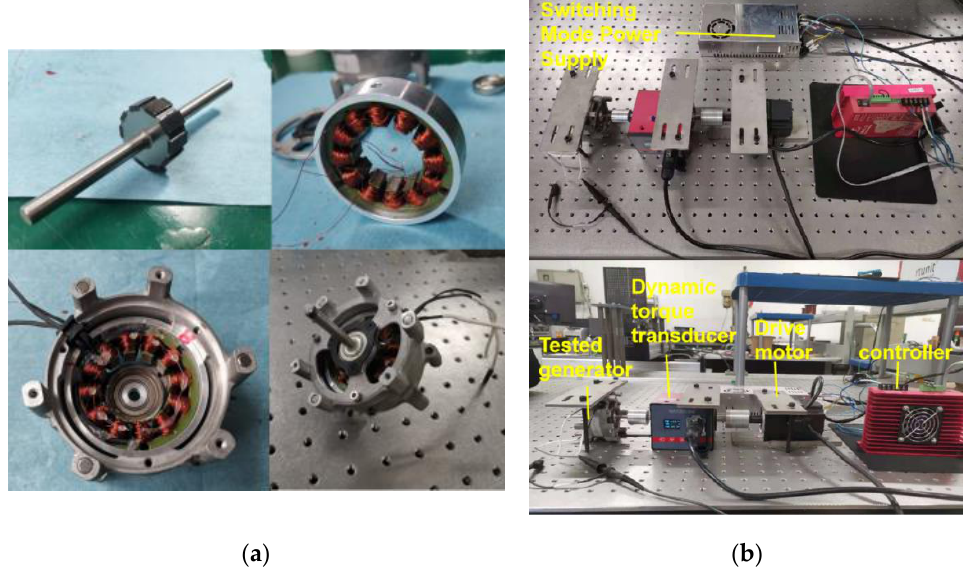
Figure 11. ( a ) Physical diagram of the motor; ( b ) Experimental platform. Table 9. Main technical parameters of experimental